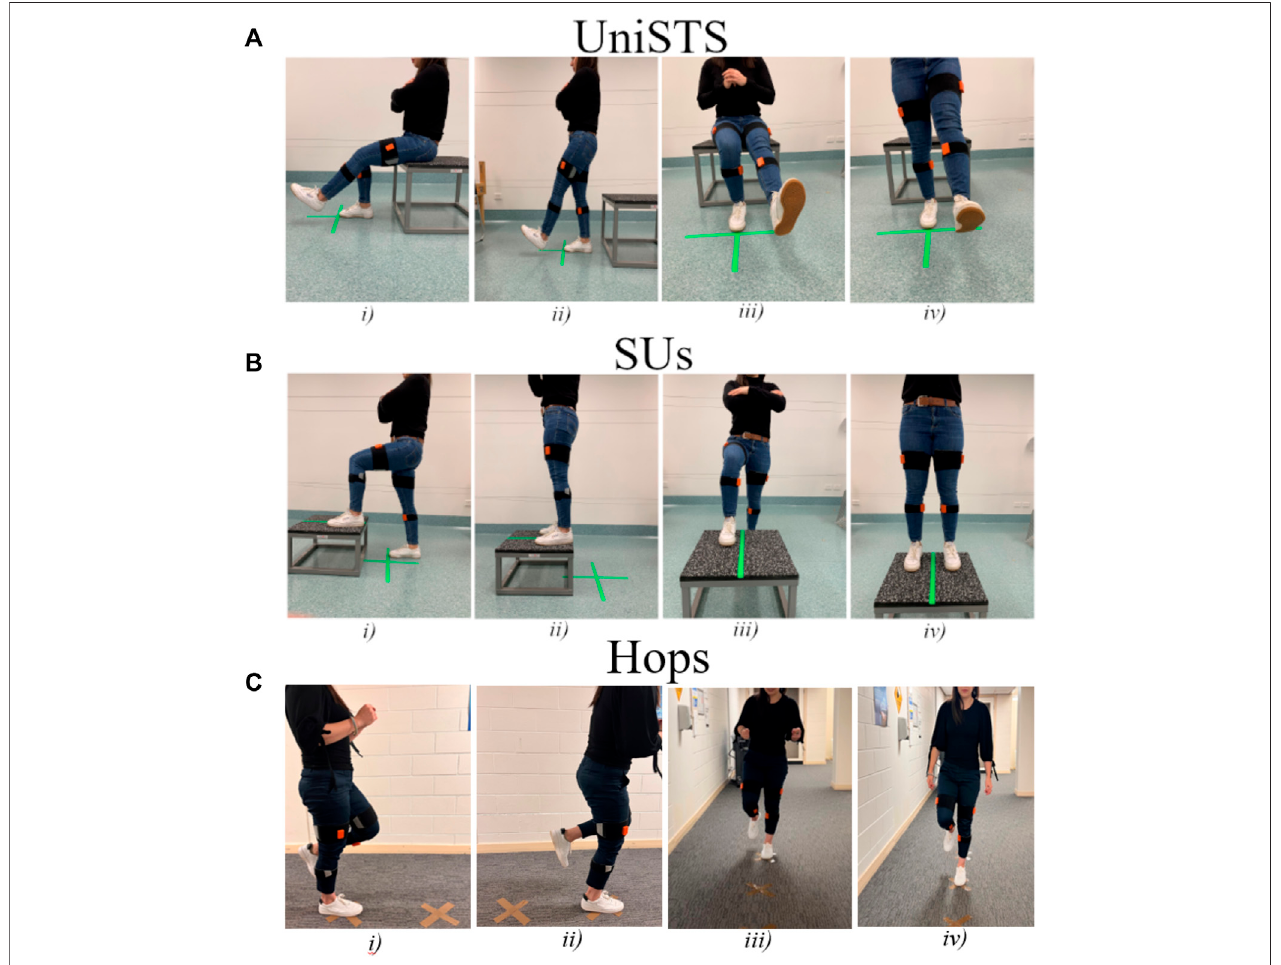
FIGURE1| Thestandardizationproceduresfor (A) UniSTS, (B) SUs,and (C) Hopsinstartingandendingposition,withasagittalplaneviewandfrontalplaneview. Two inertial sensors were attached to the shanks and two to the thighs of the participants.